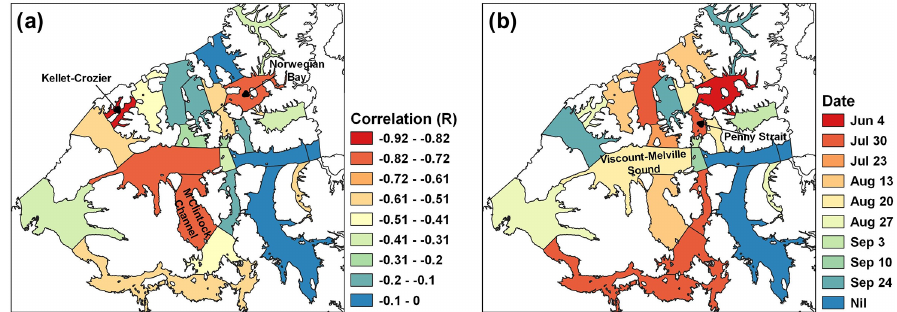
Figure 9. Spatial distribution of the (a) strongest detrended correlation ( R ) between RADARSAT-2 peak melt pond fraction ( f pk ) and weekly sea ice area and (b) week of occurrence.